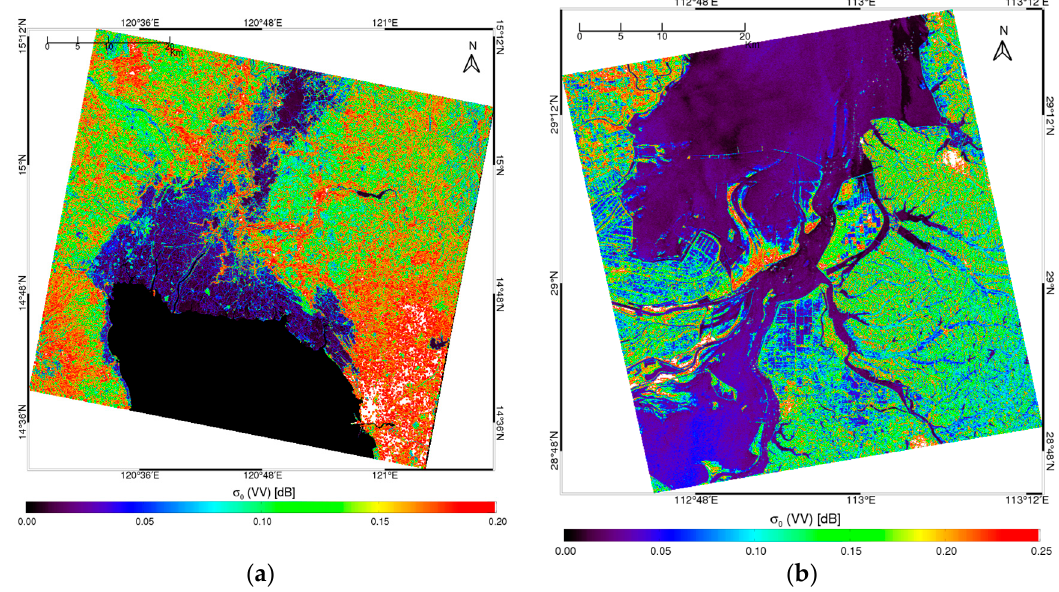
Figure 4. Backscattering coefficients of VV-polarizations observed from SENTINEL-1A ( a ) around the Pampanga River in the Philippines on 26 October 2015 at 21:46 UTC and ( b ) around the Poyang and Dongting Lakes in China on 3 August 2016 at 10:27 UTC.